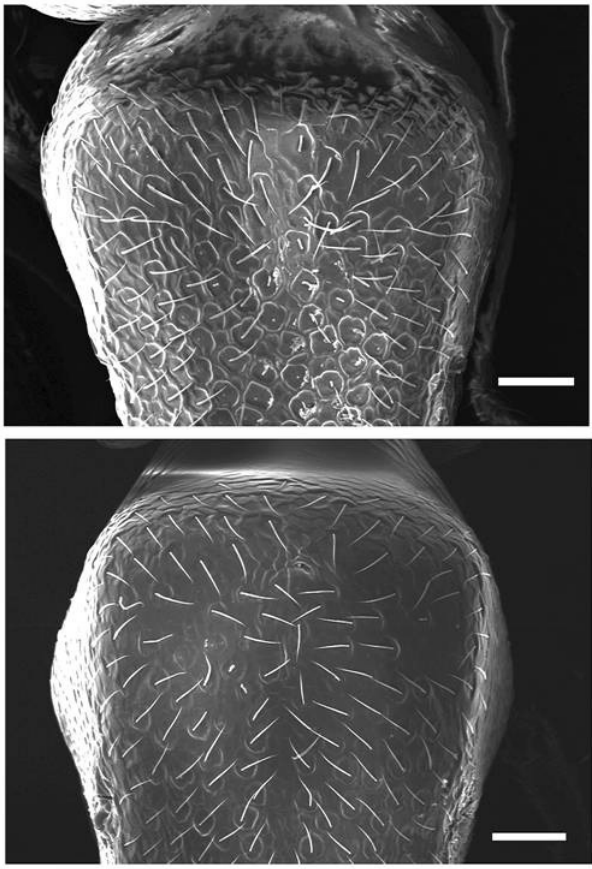
Fig 7. SEM images of the dorsal promesonotum of the worker caste. The top is lineage D of Cardiocondyla sl. kagutsuchi and the bottom is Cardiocondyla strigifrons . Each scale bar is 50